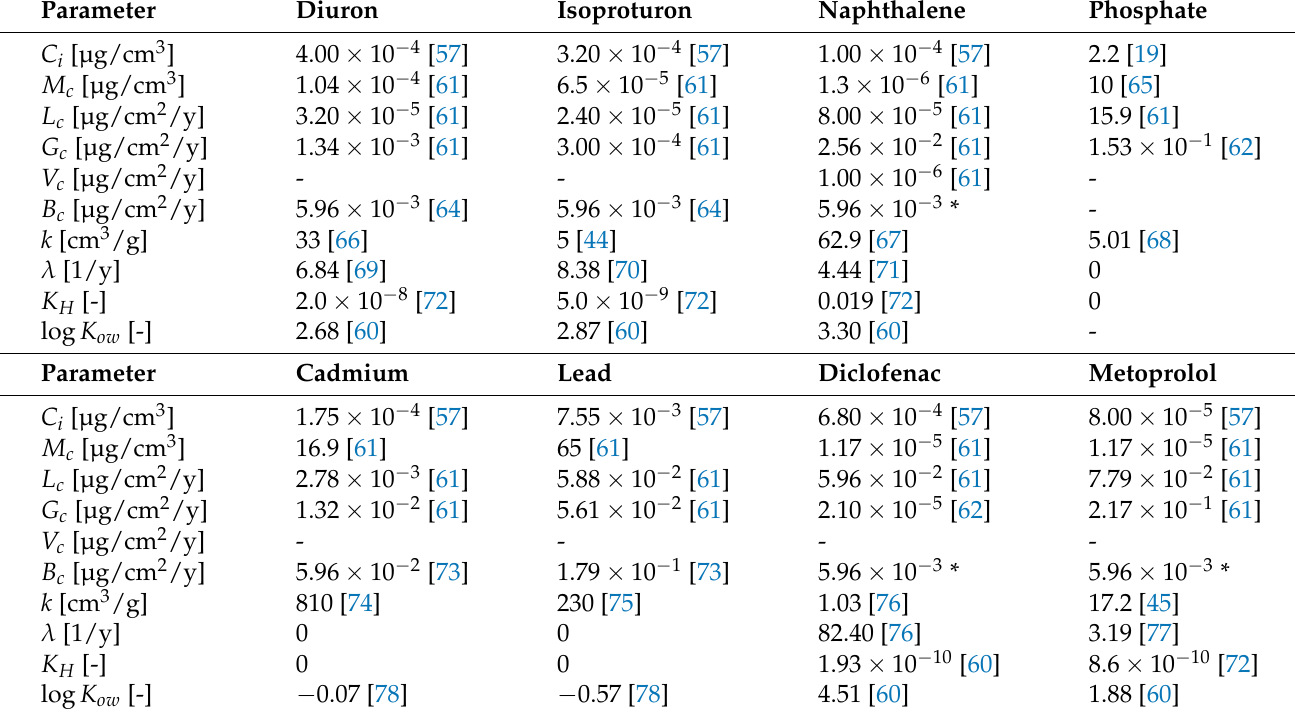
Table 2. Properties of the contaminants considered in this example: the contaminant concentration in the irrigation water C i , the soil quality standard M c , the groundwater quality standard L c , the surface water quality standard G c , the air quality standard V c , the crop quality standard B c , the soil adsorption coefficient k , the degradation rate constant λ , the Henry’s constant K H , and the octanol-water partition coefficient K ow . Data marked with an asterisk (*) denote that no crop quality standard was available for this contaminant, and thus the values of diuron are used instead as a rough